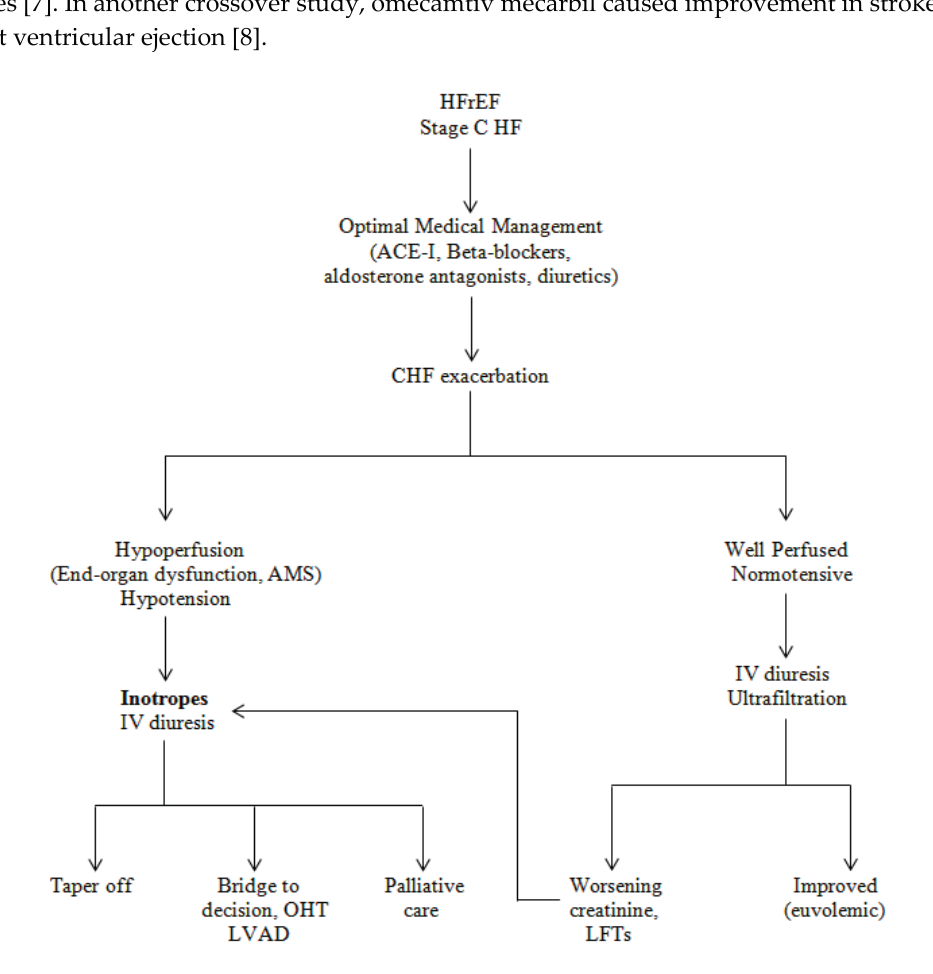
Figure 1. Approach to use of inotropic agents in patients hospitalized with acute decompensated systolic heart failure. HFrEF = Heart failure with reduced ejection fraction; ACE-I = Angiotensin converting enzyme inhibitor; CHF = congestive heart failure; AMS = Altered mental status; IV = intravenous; OHT = Orthotropic heart transplant; LVAD = Left ventricular assist device; LFT = Liver function